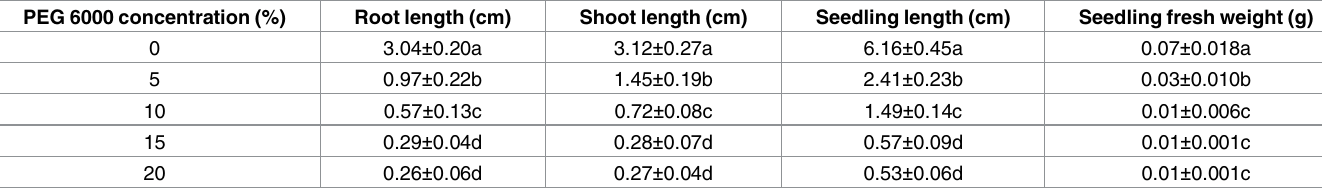
Data are mean ± SD (n = 6). Values marked by different letters (a, b, c, d) within a column are significantly different at P < 0.05. Same as